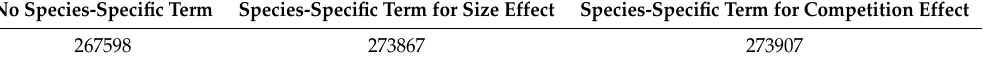
Table A1. DIC for models including no species-specific term or species-specific term for size or